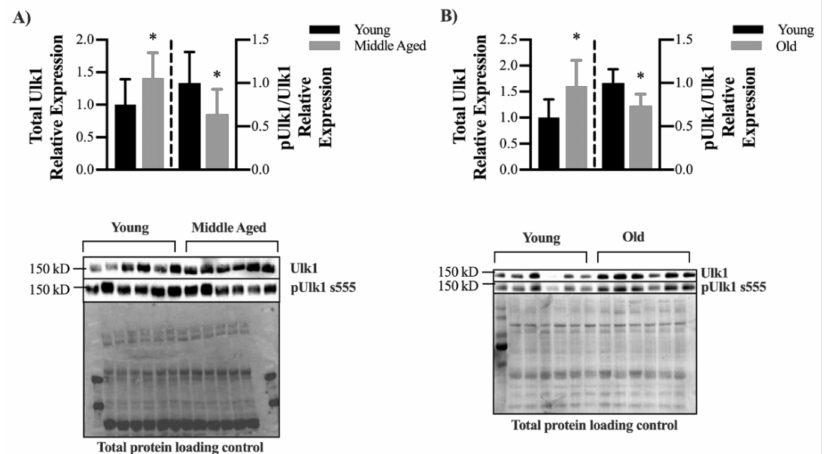
Figure 8. Decline in Ulk1 phosphorylation with age ( A ) Relative expression of total Ulk1 and pUlk1 normalized to Ulk1 in young (4 months) and middle-aged (16 months) mice and representative immunoblot images. Mean ± SD n = 7 mice. * = significantly different from young. ( B ) Relative expression of total Ulk1 and pUlk1 normalized to Ulk1 in young (20–40 y) and old (60–80 y) hu- man muscle biopsy samples and representative immunoblot images. Mean ± SD n = 6 samples. * = significantly different from young. Bars on the left of the dashed lined correspond to the left y -axis, and bars on the right of the dashed line correspond to the right y